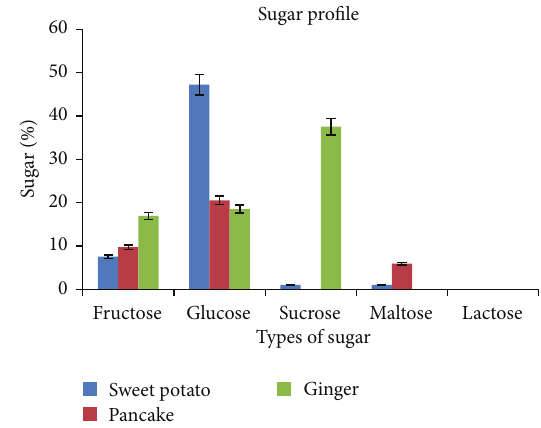
Figure 1: Sugar profile of sweet potato starch, pancake, and ginger